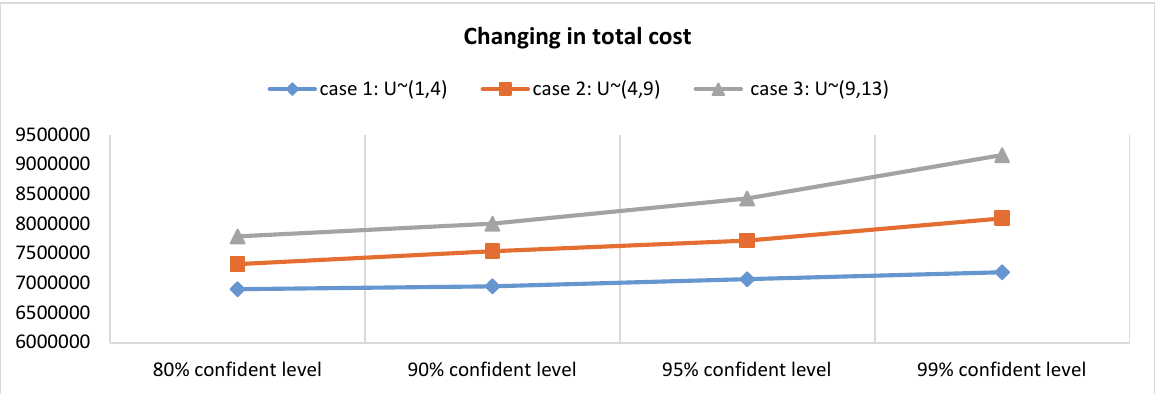
Fig. 4. Effect of Rejection Percentage on Total Cost